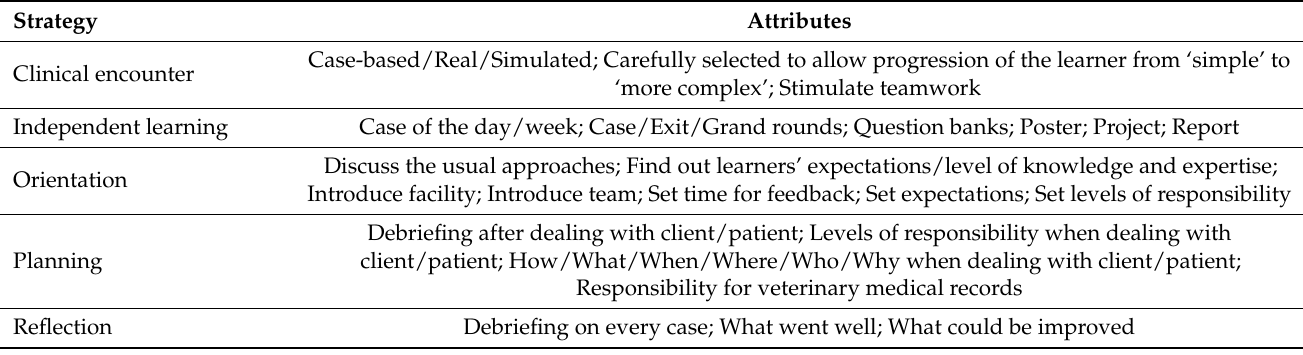
Table 3. Structuring the clinical teaching for high